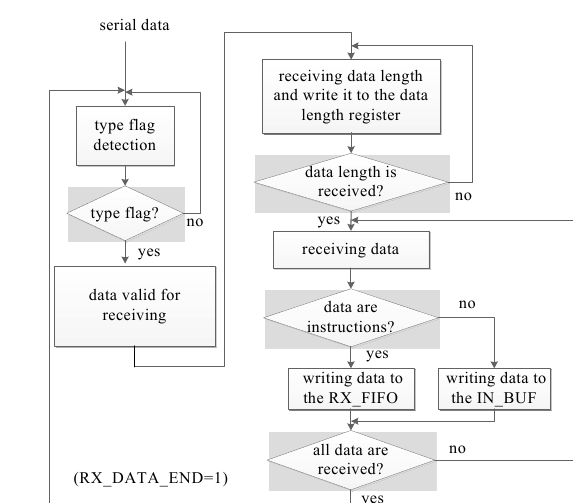
Figure 5. Data receiving.